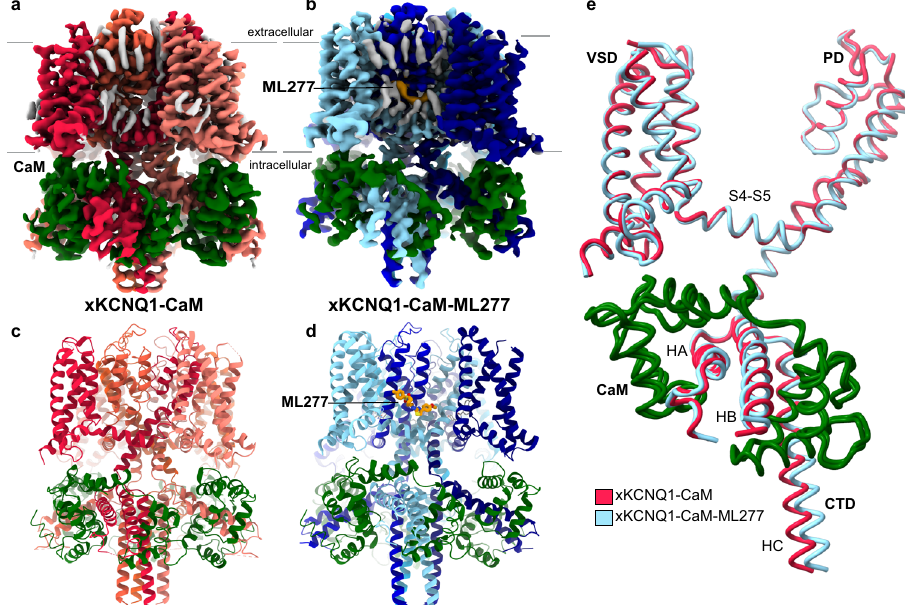
Fig. 1 Cryo-EM maps of Xenopus KCNQ1-CaM alone and in complex with ML277. a Cryo-EM density map of Xenopus KCNQ1-CaM (xKCNQ1-CaM), and its model structure ( c ). CaM is colored dark green and KCNQ1 subunits are in shades of red. b xKCNQ1-CaM in complex with ML277 and its model structure ( d ). CaM and ML277 are colored dark green and orange, respectively. KCNQ1 subunits are in shades of blue. Additional densities, likely representing unmodeled detergent or lipid molecules are shown in gray. For further analysis of these densities, see Supplementary Fig. 7. e Overall superposition of a single subunit of xKCNQ1-CaM and xKCNQ1-CaM-ML277 shows a visible twist in the C-helix coiled-coil domain (CTD). HA-HC refers to helices within the C-terminal domain of